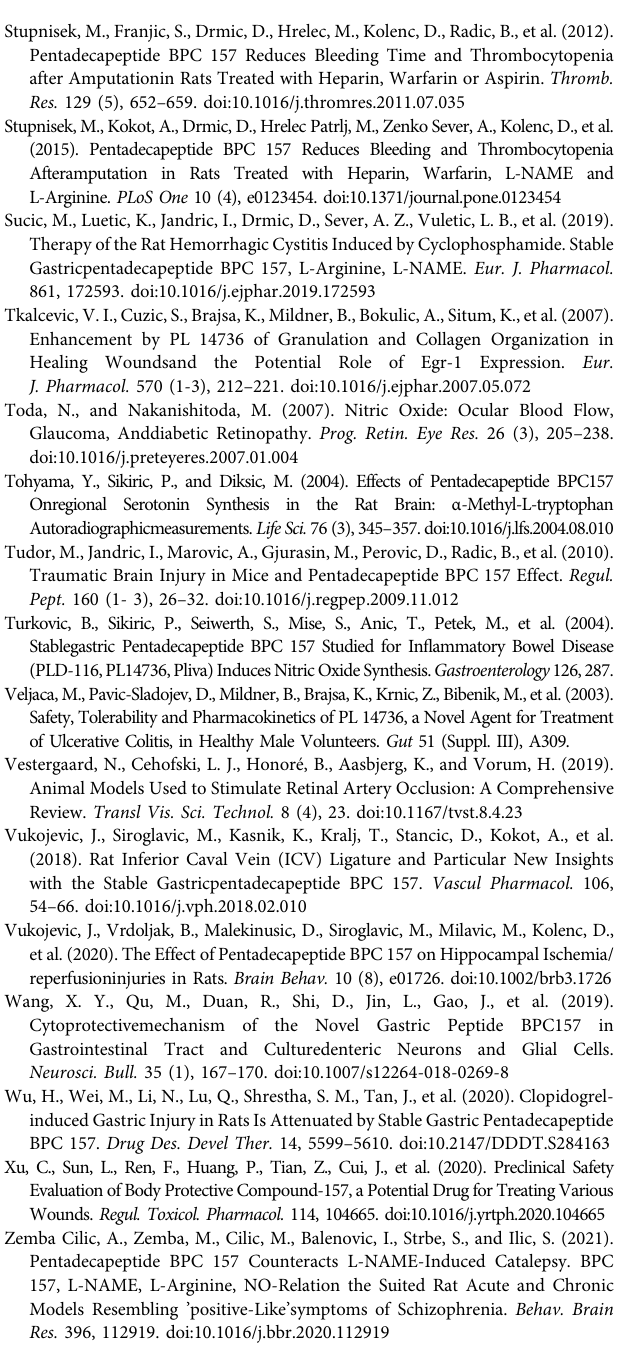
Table Gastric Pentadecapeptide BPC 157, Robert ’ s Stomachcytoprotection/adaptive Cytoprotection/organoprotection, and Selye ’ s Stress Copingresponse: Progress, Achievements, and the Future,